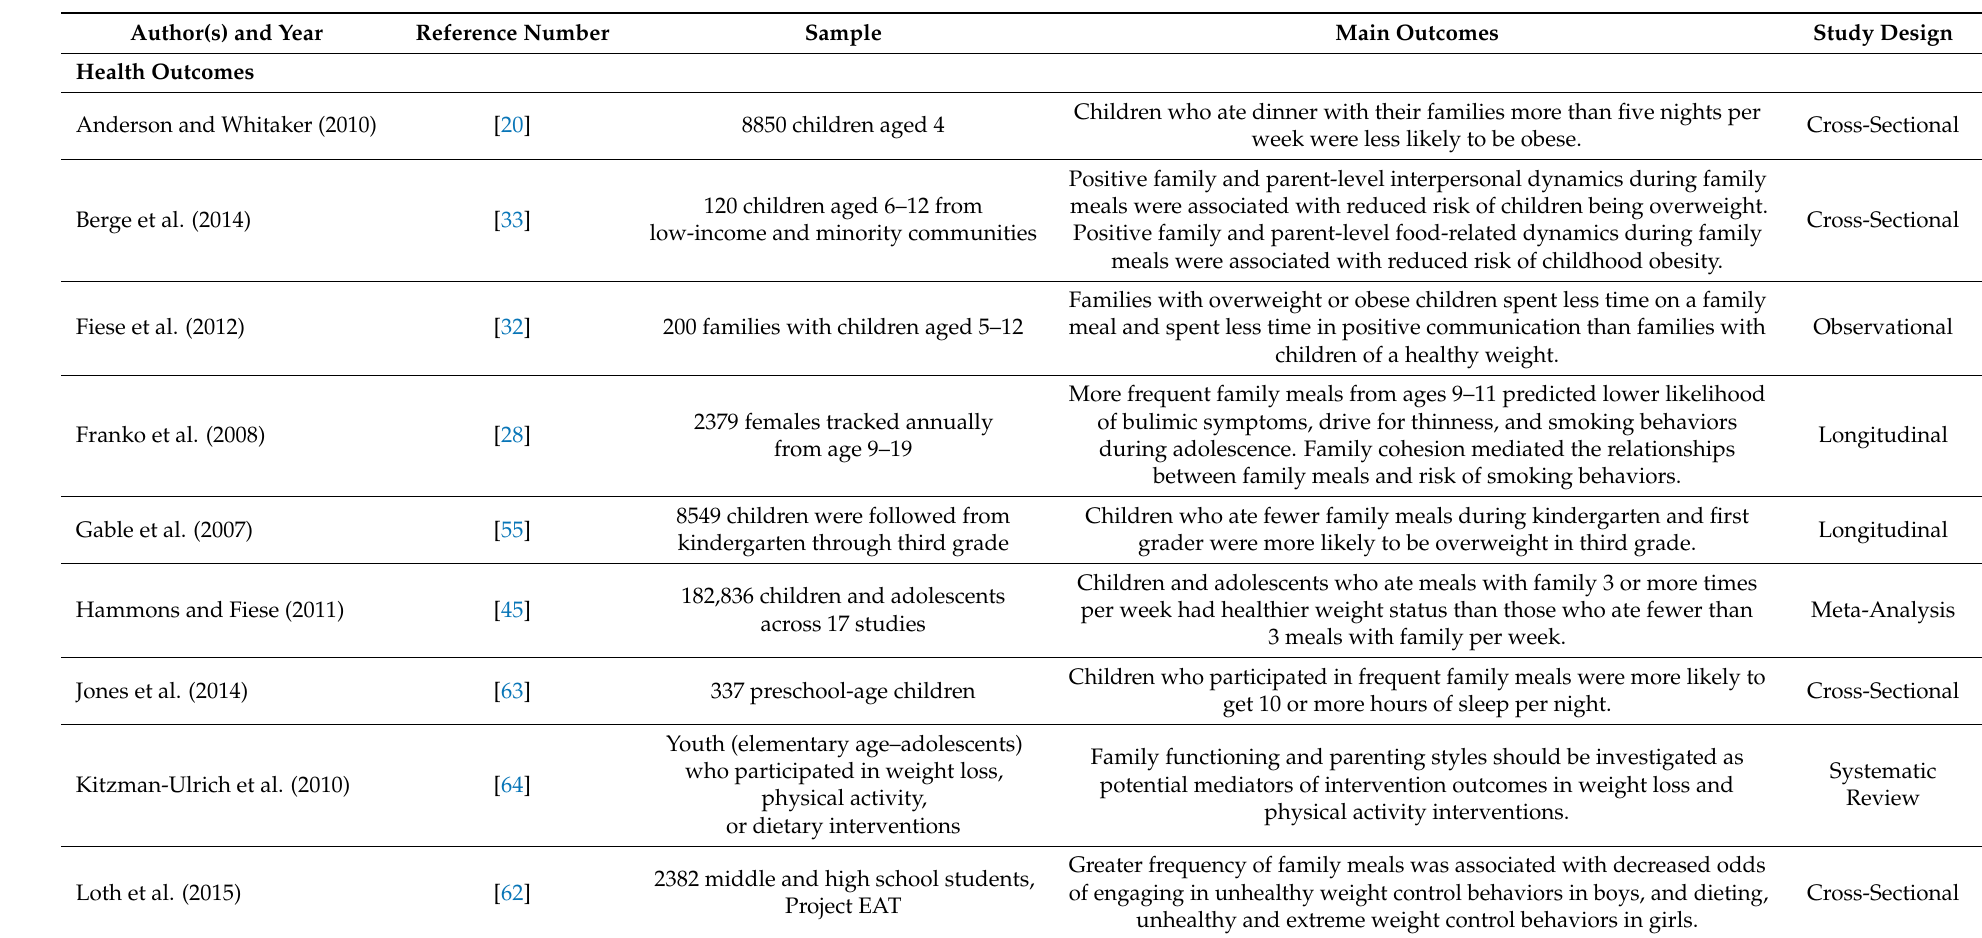
Table 2. Summary of Health